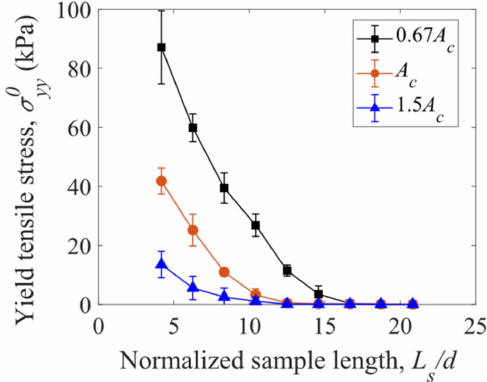
Figure 14. Yield tensile stress versus sample length with various cross-sectional areas of the samples of straight fibers ( κ = 0).